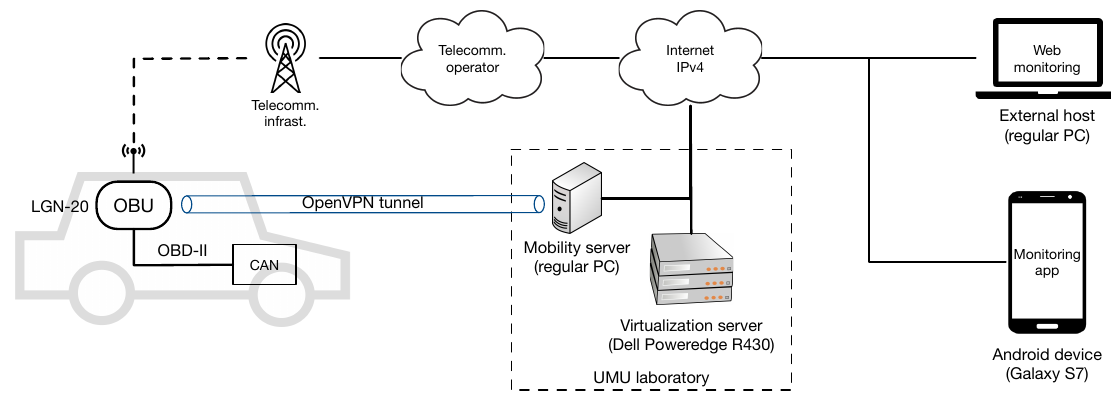
Figure 3. Deployment carried out in the